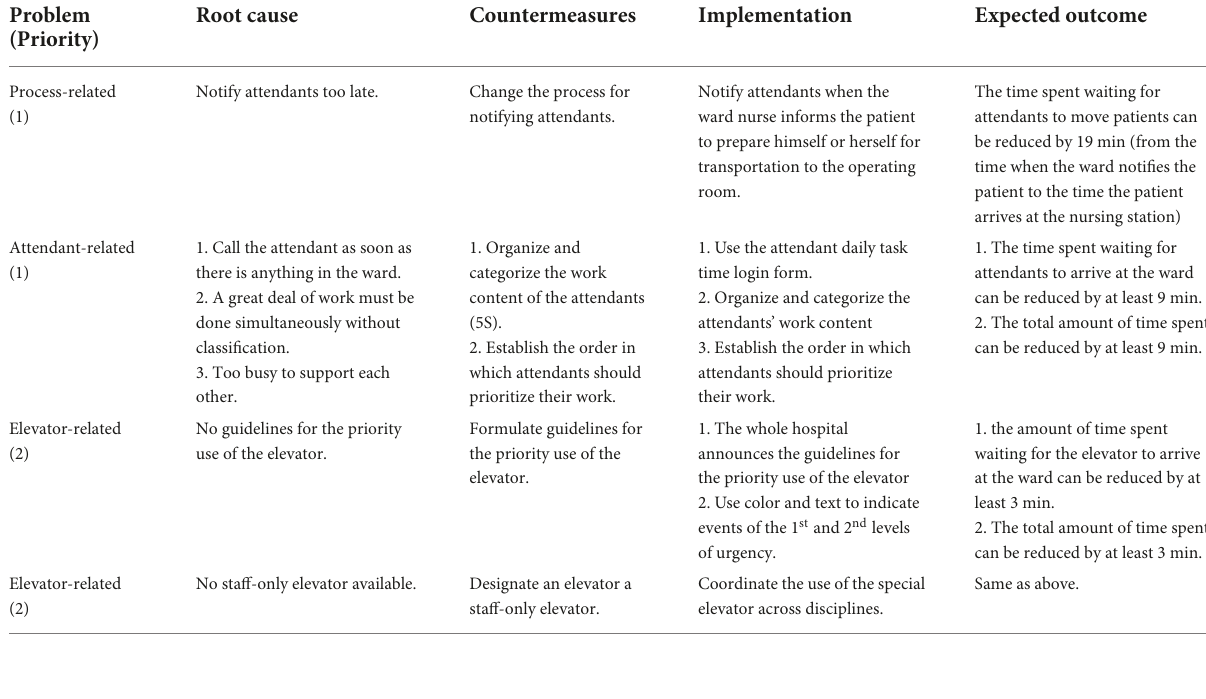
TABLE 3 Formulate and implement countermeasures.